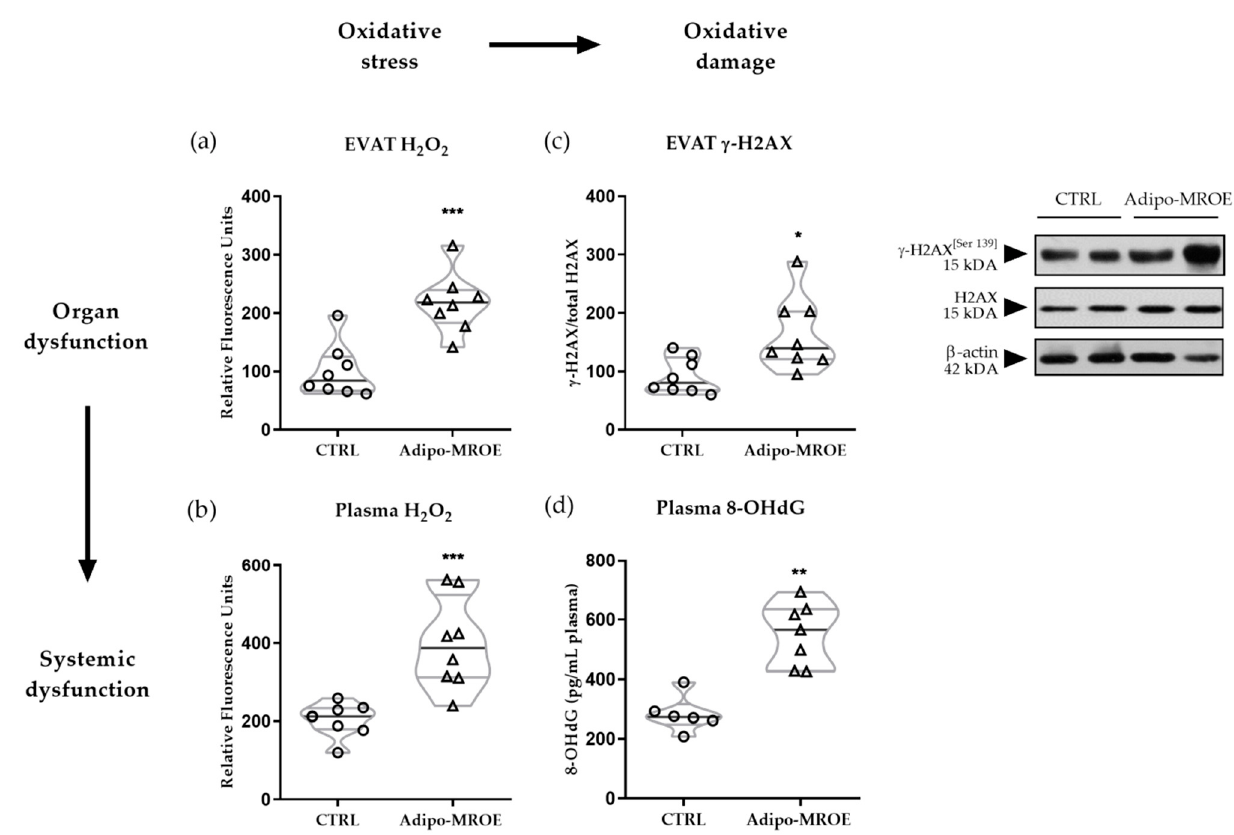
Figure 2. Adipocyte-MR overexpression induces EVAT and plasmatic oxidative stress (OS), with consequent DNA damage in adipocyte-MR overexpressing mice. ( a , b ) H 2 O 2 concentrations, as measured with Amplex Red assay, are increased in EVAT and plasma of Adipo-MROE mice, showing organ and systemic OS. The order of magnitude is the nmol/mg (tissue) or nmol/mL (plasma). ( c , d ) EVAT phosphorylation of histone H2A.X—as measured by Western blot—and plasma 8-OHdG levels—as measured by ELISA—are increased in Adipo-MROE mice, showing the existence of oxidative DNA damage. Data are expressed as violin plots with quartiles and individual dots. n = 6–8 mice per group; * p < 0.05; ** p < 0.01; *** p < 0.001, Adipo-MROE vs. control. 8-OHdG: 8-Oxo-2’-deoxyguanosine; EVAT: epididymal visceral adipose tissue (AT); MR: mineralocorticoid receptor.